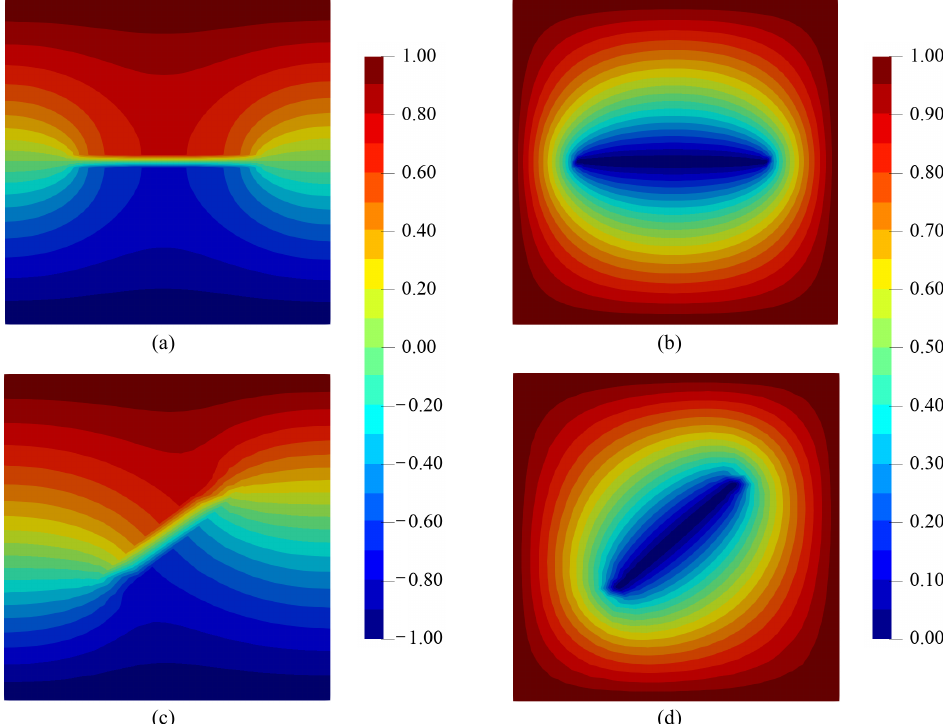
Figure 6. Temperature contour plots: ( a ) horizontal center crack (adiabatic case); ( b ) horizontal center crack (isothermal case); ( c ) slant center crack (adiabatic case); ( d ) slant center crack (isothermal